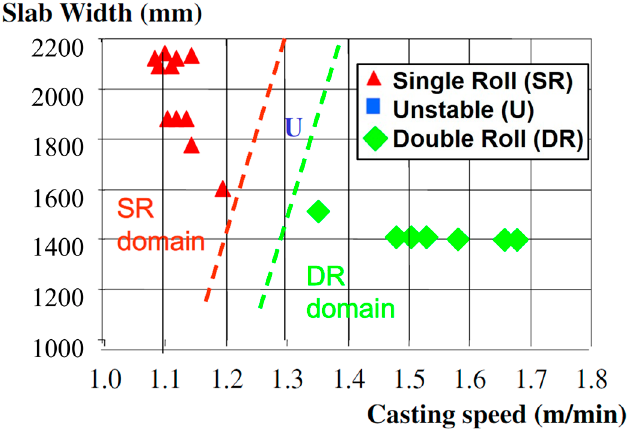
Figure 17. Unstable flow regime between single and double-roll flow patterns (4.4 t/min throughput) [16]